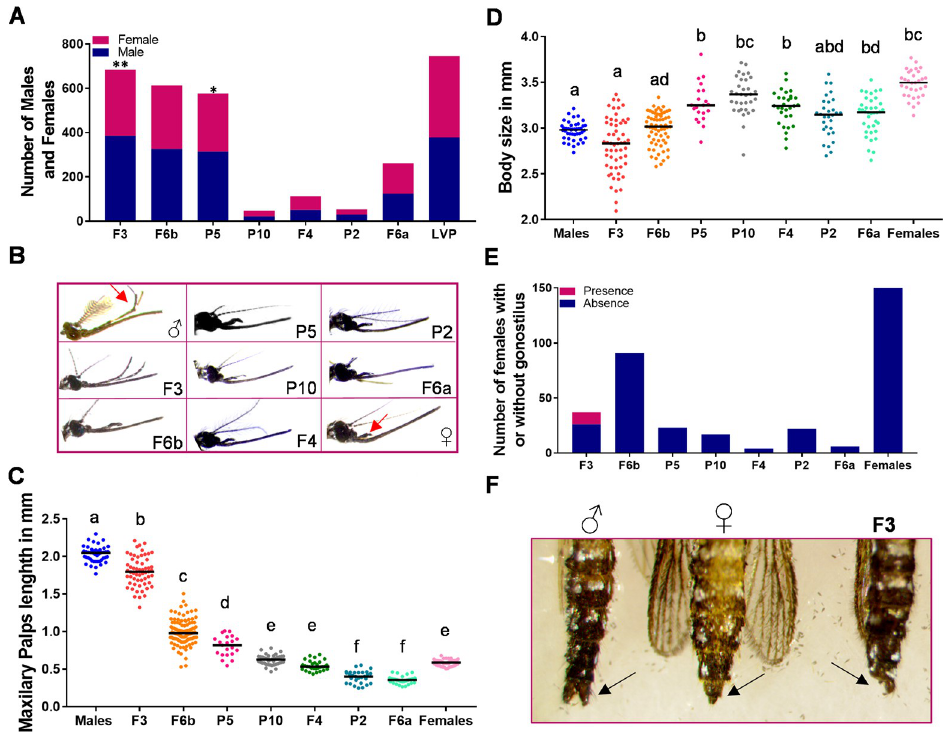
Fig 2. Intersex phenotypes in transgenic Ae . aegypti with Nix under the control of the TRE. ( A ) Sex ratio of each transgenic line. Binomial test was used to access statistical significance ( B ) Representative images of the head of the seven transgenic lines, male and female Liverpool strain depicting different maxillary palp lengths, red arrow indicating the maxillary palps from male and female wild type. ( C ) Maxillary palp size in millimeters from female mosquitoes of the seven transgenic lines, male and female from Liverpool in the absence of Dox. Bars represent the median. ( D ) Body size in millimeters from female mosquitoes of the seven transgenic lines, male and female from Liverpool strain in the absence of Dox. Bars represent the median. ( E ) Number of females from each transgenic line in absence of Dox that developed the male genitalia with the presence of one gonostilus ( F ) Pictures of F3 transgenic line, male and female Liverpool strain abdomen, the arrows are pointing to the genitalia depicting the presence (male), absence (female) or the presence of only one gonostilus (F3 line). ( C ) and ( D ) Numbers followed by different letters are statistically different P � 0.05 (Tukey’s